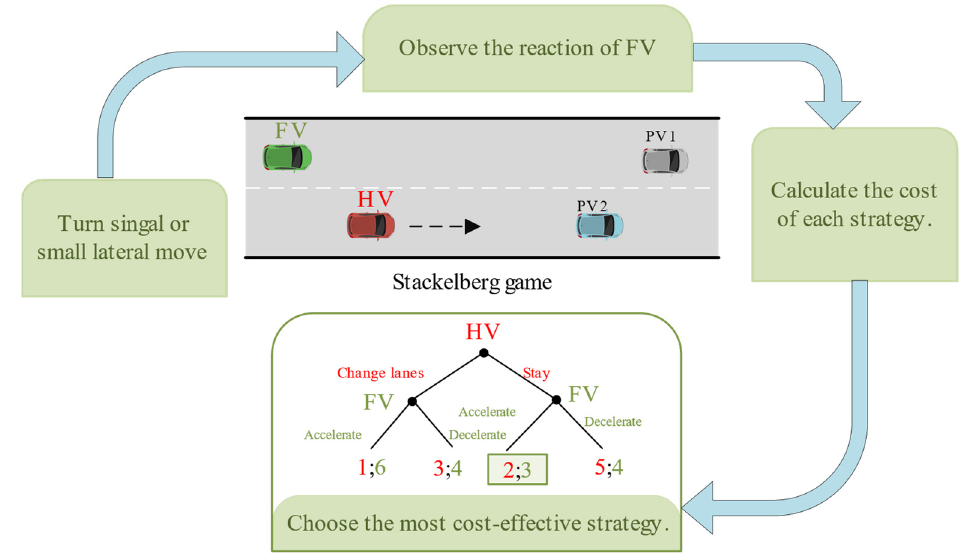
Figure 2. Stackelberg game theory.